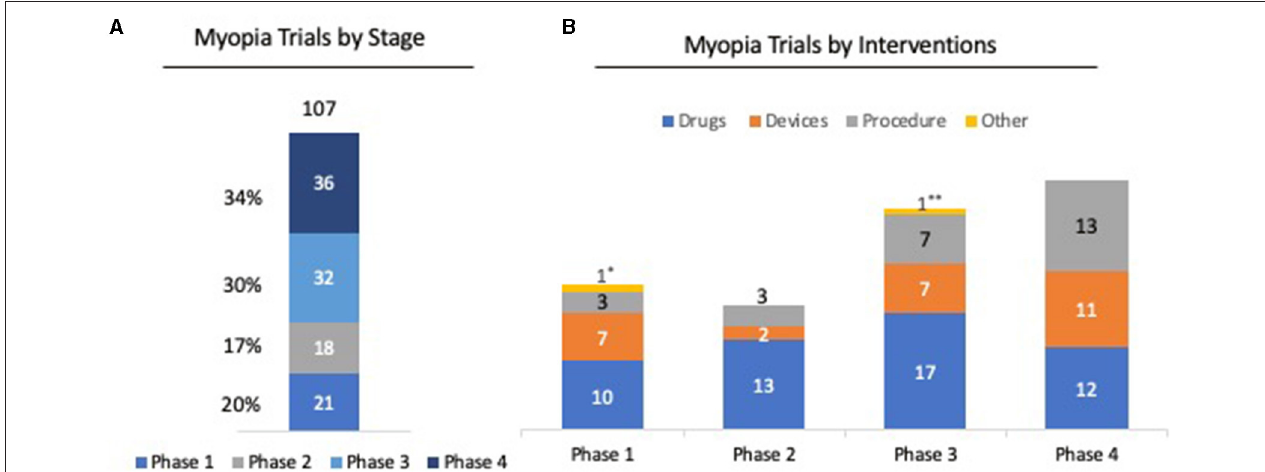
FIGURE 1 | Clinical trial trends in myopia. (A) Among 107 clinical trials registered for myopia, 36 (34%) of clinical trials have entered or completed Phase 4; 32 (30%) are in Phase 3; 11 (7%) are in Phase 2; and 21 (20%) are in Phase 1 stage. (B) Analysis of clinical phases by intervention shows that 52 trials (48%) were for drugs for myopia, 27 trials (25%) were on devices, and 26 trials (4%) were on procedures, such as LASIK and SMILE. * Clinical trial on dietary supplement for myopia. ** Clinical trial on family-based outdoor program for myopia. Source: ClinicalTrials.gov. Keyword: Myopia; Phase 1-4; status; active but not recruiting/recruiting/not yet recruiting/completed Accessed Feb